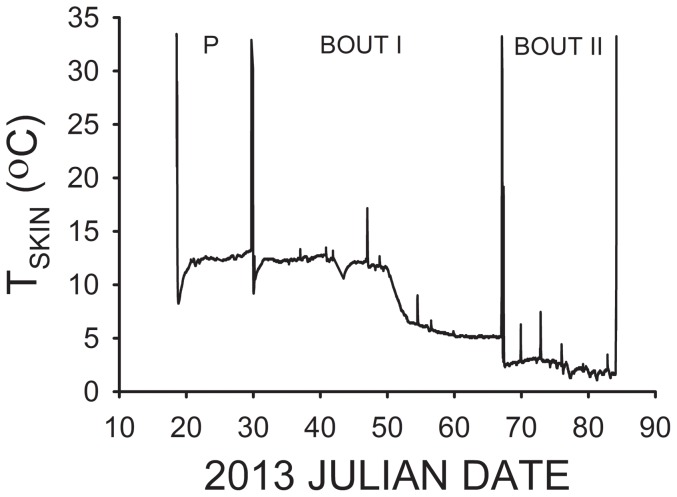
Tskin recordings of an individual male E. fuscus during hibernation.Torpor is when Tskin <23°C. The torpor bout labeled “P” is that which occurred after the arousal episode that was provoked by the capture and handling of this bat. Two subsequent natural torpor bouts occur after normal (spontaneous) arousal episodes. The bat arouses from torpor and leaves the mine at the end.